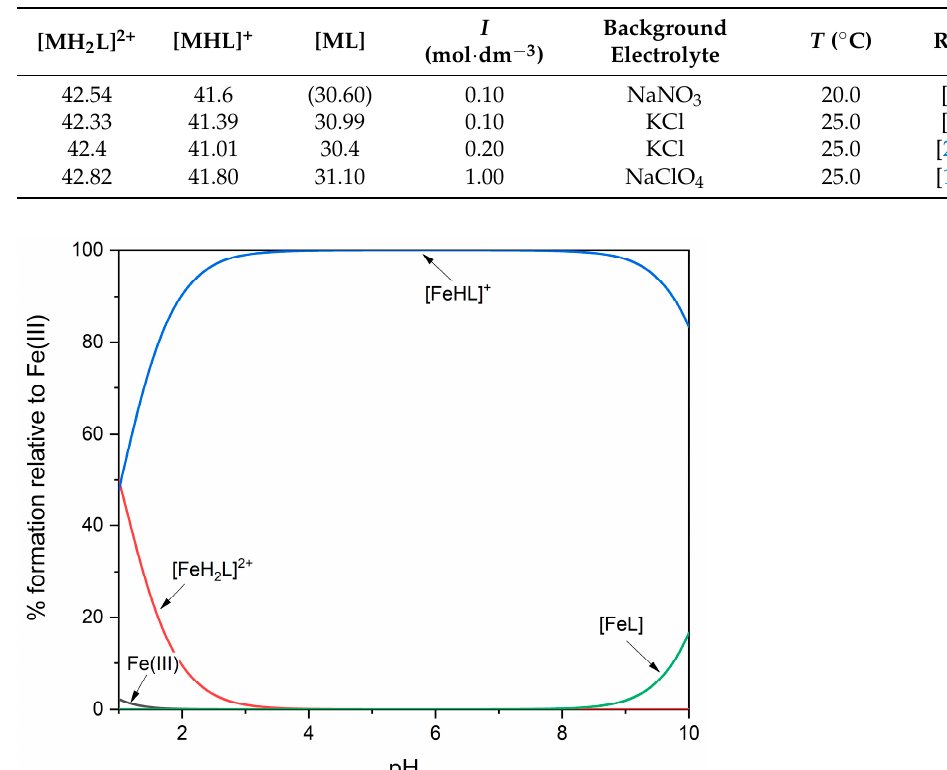
Table 2. Overall complex-formation constants (log β ) of DFOB with the Fe(III) ion under different experimental conditions. The constant in parentheses corresponds to the formation of the 1:1 complex of Fe(III) with DFOB protonated at its amino group and therefore refers to the equilibrium: Fe 3+ + HL 2- = MHL + .